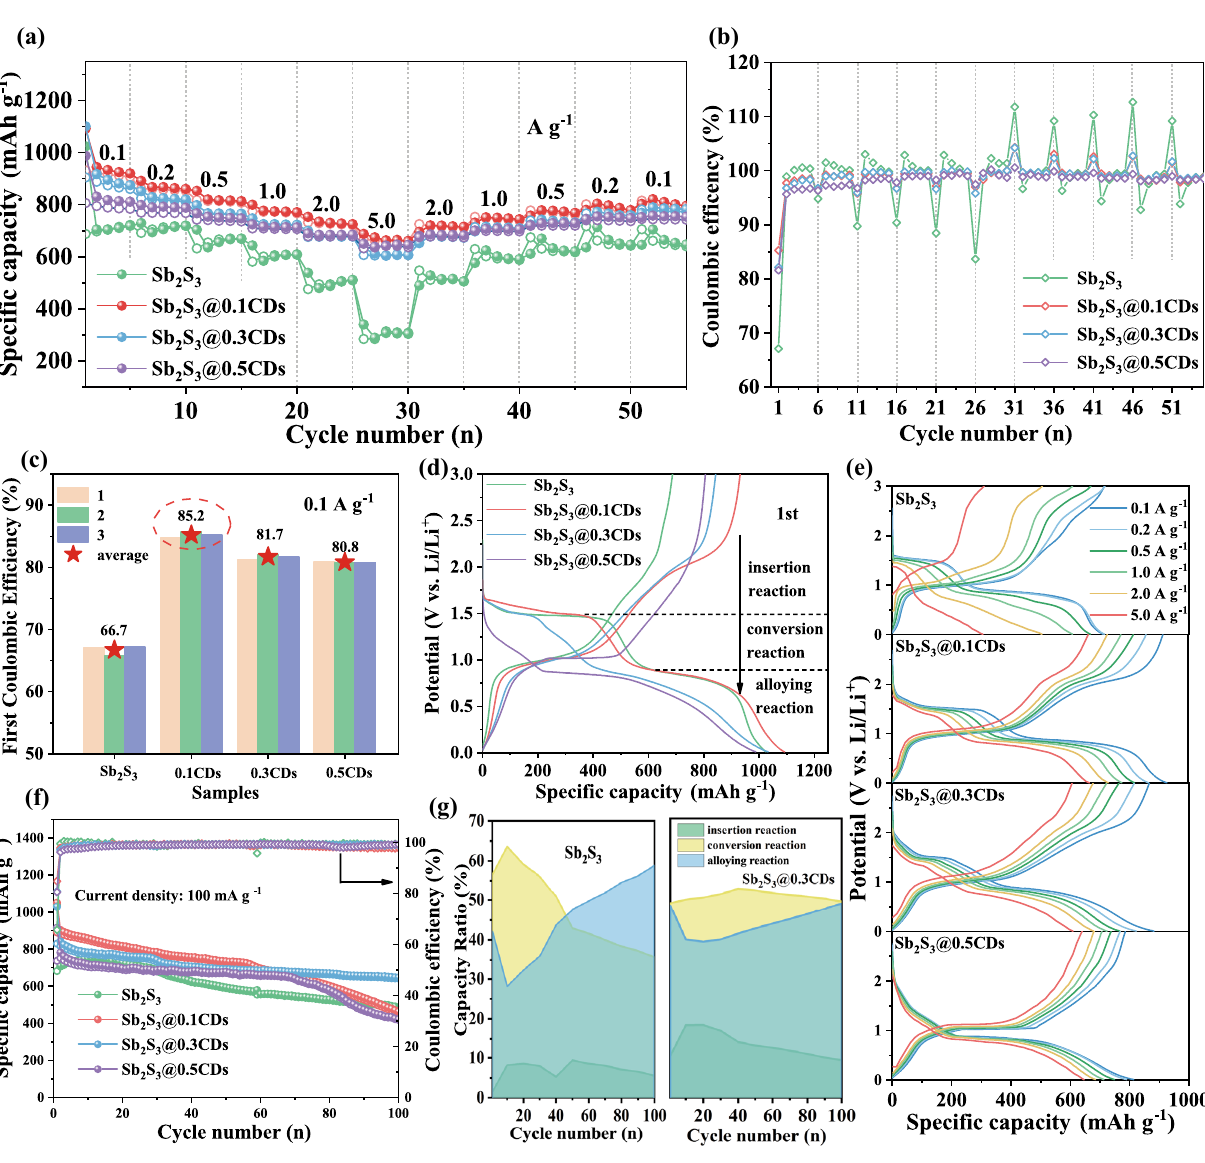
Fig. 5 Lithium storage performance. a Rate capability and b Coulombic efficiency of the four samples at various current densities from 0.1 to 5 A g −1 . c The initial Coulombic efficiency of the four electrodes at a density of 0.1 A g −1 . d The first discharge/charge curves of the four samples. e Discharge/charge profiles of four electrodes at the corresponding rates. f Cycling performance of the four electrodes at a density of 0.1 A g −1 . g The real-time capacity ratio of three diverse reactions when Sb 2 S 3 and Sb 2 S 3 @0.3CDs anodes are discharged/charged at a current of 0.1 A g